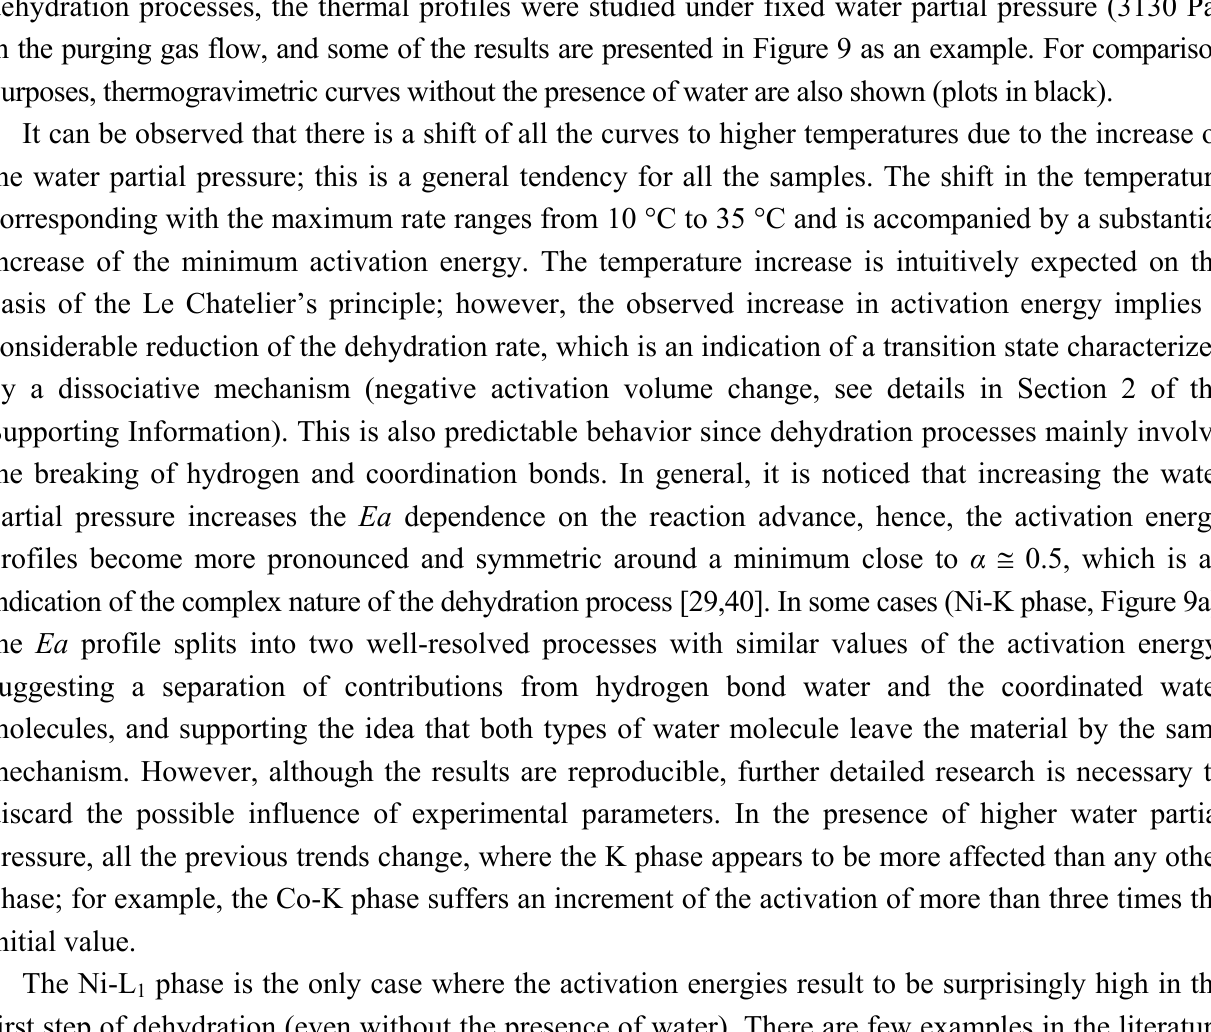
Figure 8. SEM micrograph of the as prepared Ni-L